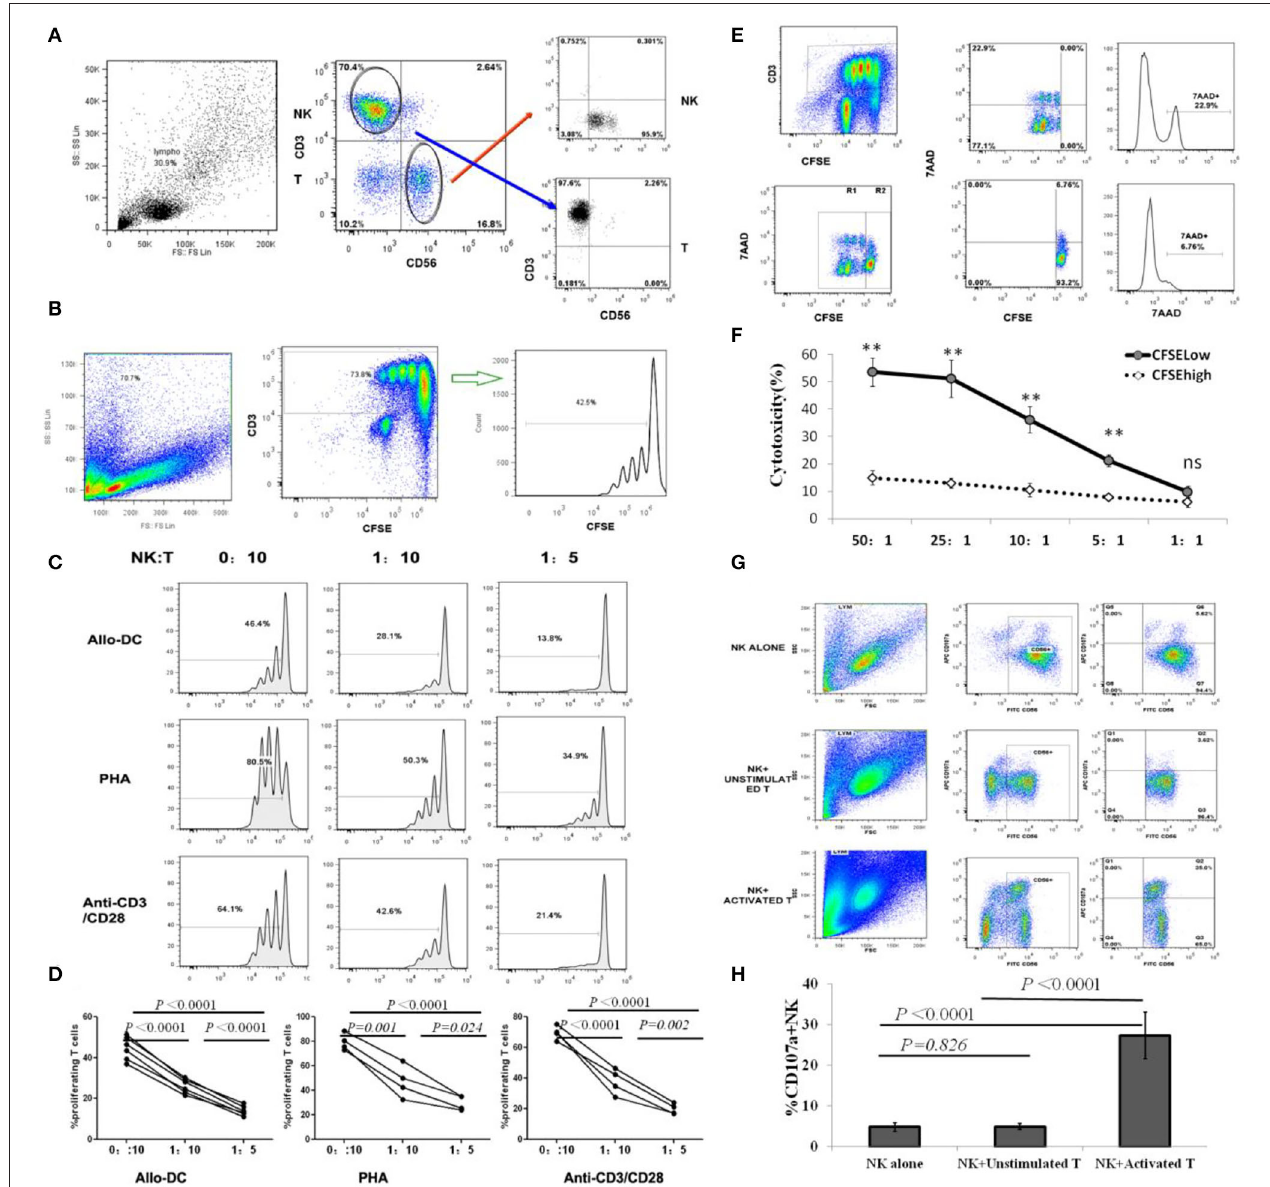
FIGURE 1 | NK cells inhibit T cell proliferation by selectively killing alloantigen activated T cells. (A) Representative gating strategy for NK and T cell sorting; (B) Representative gating strategy for T cell proliferation assay. (C,D) CFSE-labeled CD3 + T cells were stimulated with PHA, anti-CD3/anti-CD28 mAbs or allo-DCs, and autologous CD56 + NK cells were added at NK/T ratios of 0:10, 1:10, or 1:5. Four days later, CD3 + T cell proliferation was analyzed by flow cytometry. The percentage of proliferating T cells was defined by CFSE intensities ( n = 4). (E,F) CFSE-labeled CD3 + T cells were first stimulated with allo-DCs for 96h and then used as target cells for NK killing assays at effector:target (E:T) ratios of 50:1, 25:1, 10:1, 5:1, or 1:1. Allo-reactive T cells were distinguished by lower CFSE intensity (CFSE low ) in CD3 + T cells. 7AAD was labeled to identify dead cell and analyzed by flow cytometry ( n = 4). (G,H) Naïve T cells or T cells activated by anti-CD3/anti-CD28 mAbs were co-cultured with NK cells at an effector:target (E:T) ratio of 1:1 for CD107a degranulating assay. NK cells cultured alone were used as controls. The percentage of CD107a + in CD56 + NK cells represented the level of NK degranulation toward T cells ( n = 4). All calculated averages were defined as the parametric mean ± SD. Student’s t -tests, or two-way ANOVA analyses, were used to compare the mean among groups. ns: not significant. ** P < 0.01.